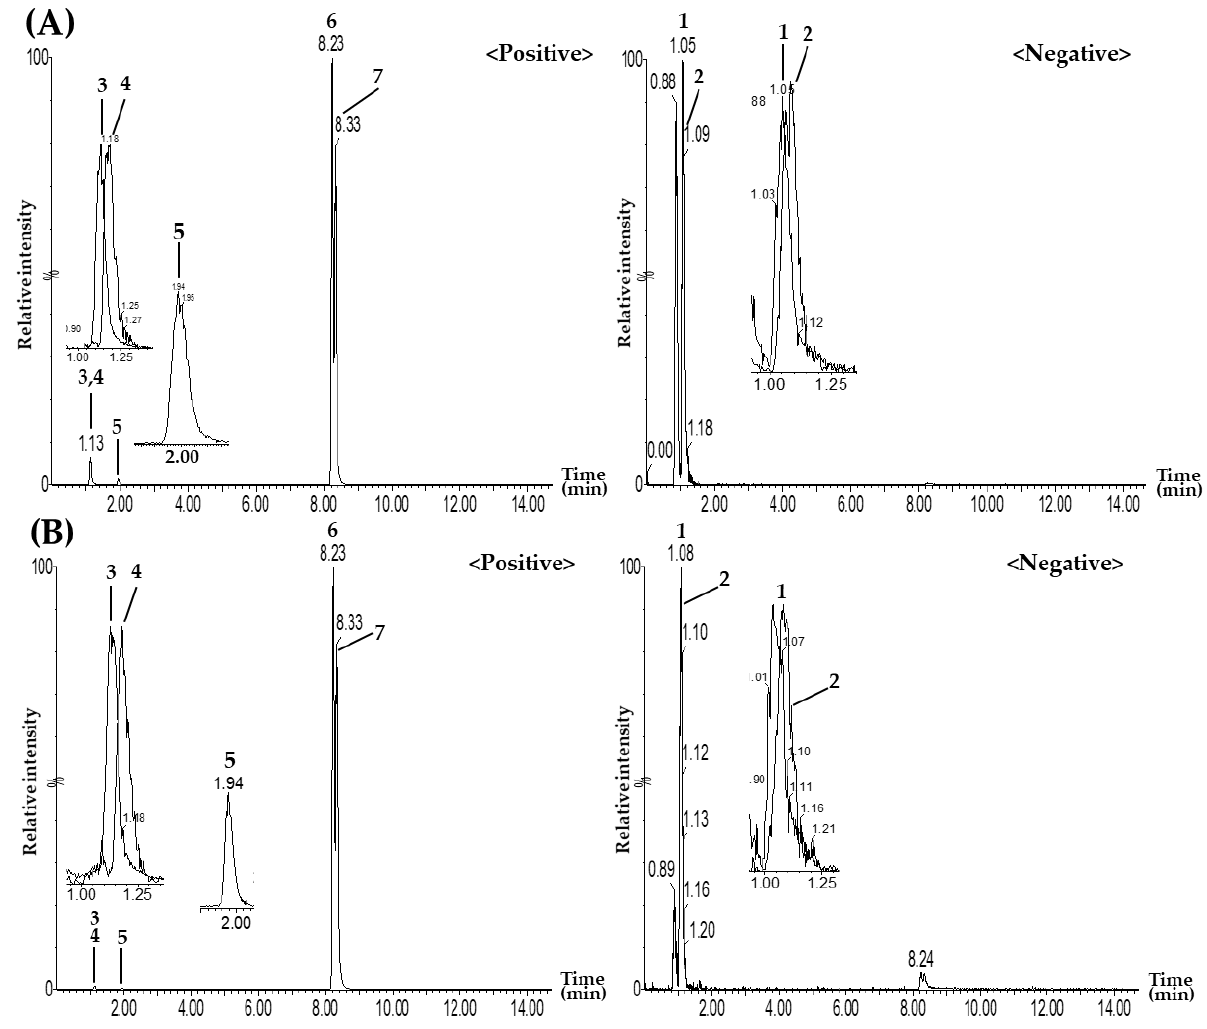
Figure 2. Representative total ion chromatograms of the standard solution ( A ) and GJD–1 sample ( B ) using UPLC–MS/MS MRM. Gallic acid (1), morroniside (2), 5-HMF (3), loganin (4), nodakenin (5), decursin (6), and decursinol angelate (7). The concentration of all analytes in the mixed standard solution was 5.00 µg/mL.